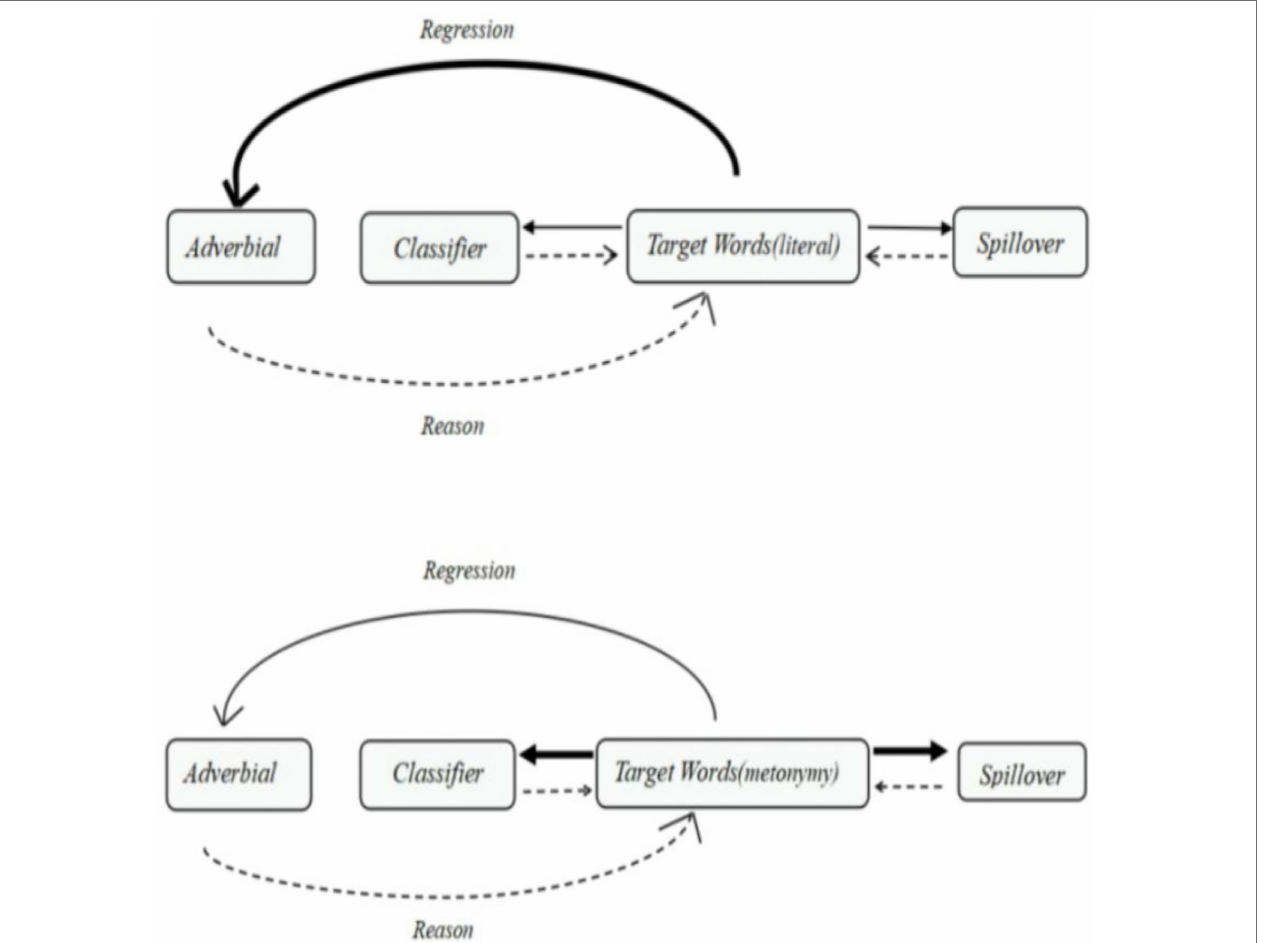
FIGURE 1 | Cognitive-psychological model for Chinese metonymy as